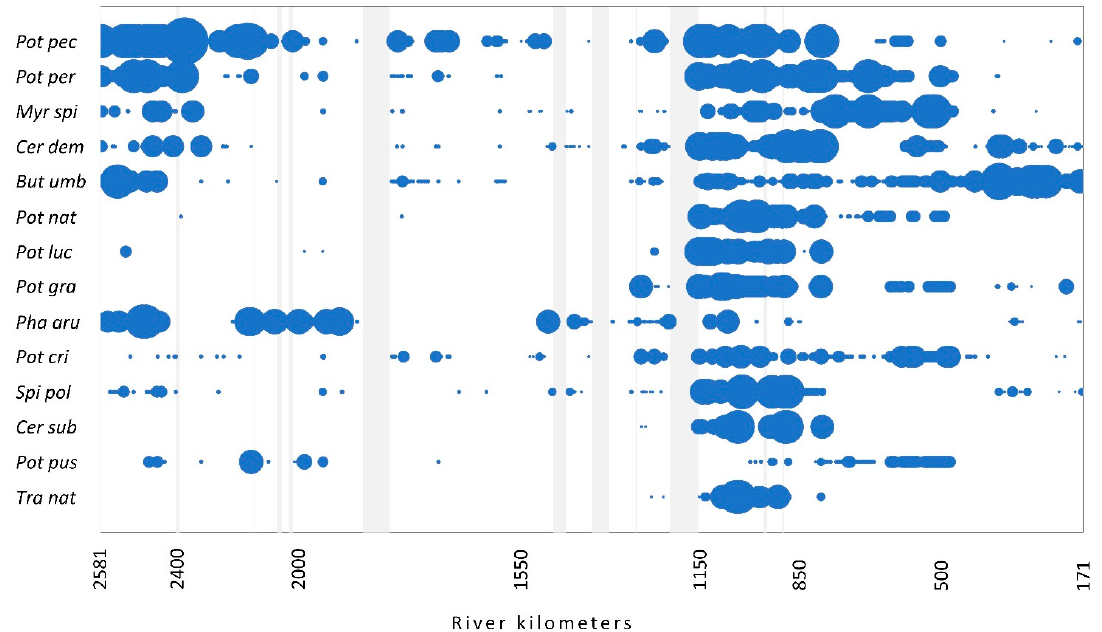
Figure 2. The occurrence of the most abundant native species (>1%) along the flow. The size of the circles shows the relative abundance of each species. Light gray vertical bars represent the sections with no data. For species abbreviations, see Figure 1. The number of species recorded in a single stretch varied along the flow, and this holds true also for species abundance. The pattern of values of both parameters along the flow reveals a similar picture showing two peaks. The first appears at the beginning of the upper section, then it gradually decreases, reaching the second peak at the end of the mid- dle section and at the beginning of the lower section of the river (Figure 3). Both parame- ters were the highest in the second part of the middle section, while the lowest values were detected at the first part of this section.